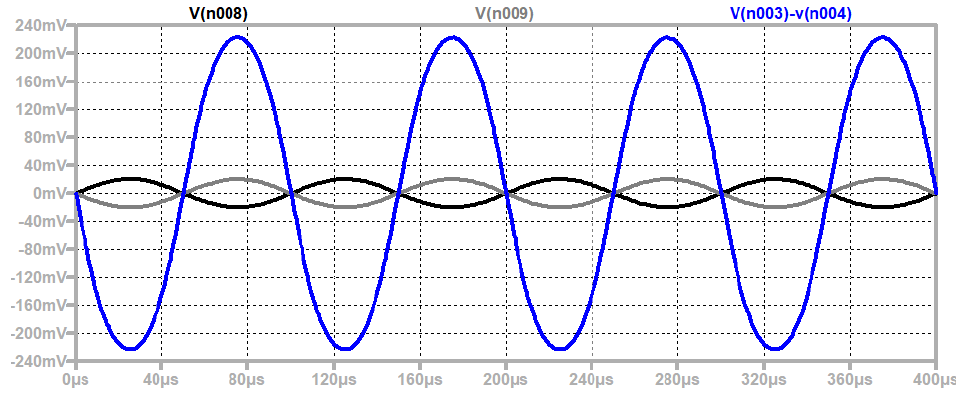
Figure 11. Time diagrams of the input and output signals of the memristor-based amplifier presented in Figure 10.